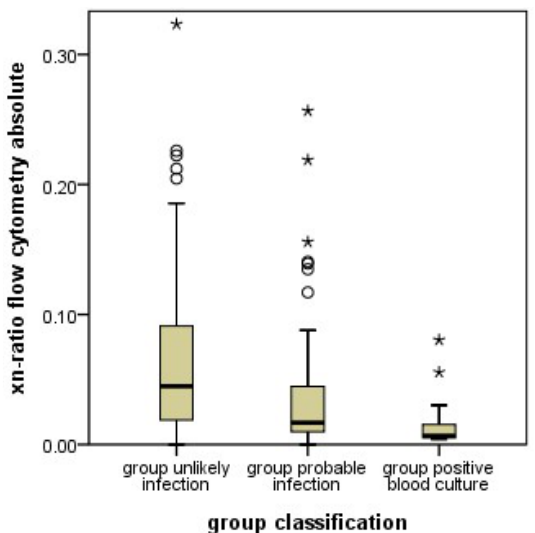
Figure 3. Boxplot of the xn-ratios (number of immature granulocytes divided by the total number of granulocytes) as counted by the Sysmex XN-9000 ® flow cytometers in the unlikely infection (UI), probable infection (PI) groups, and the positive blood culture (PC) subgroup. The PI group had lower xn-ratios than the UI group ( p < 0.001). This effect was even stronger in the PC subgroup of PI with positive blood culture. The boxes show median, and interquartile range, the whiskers 95% confidence range, ○ = outliers, ★ = extreme outliers.